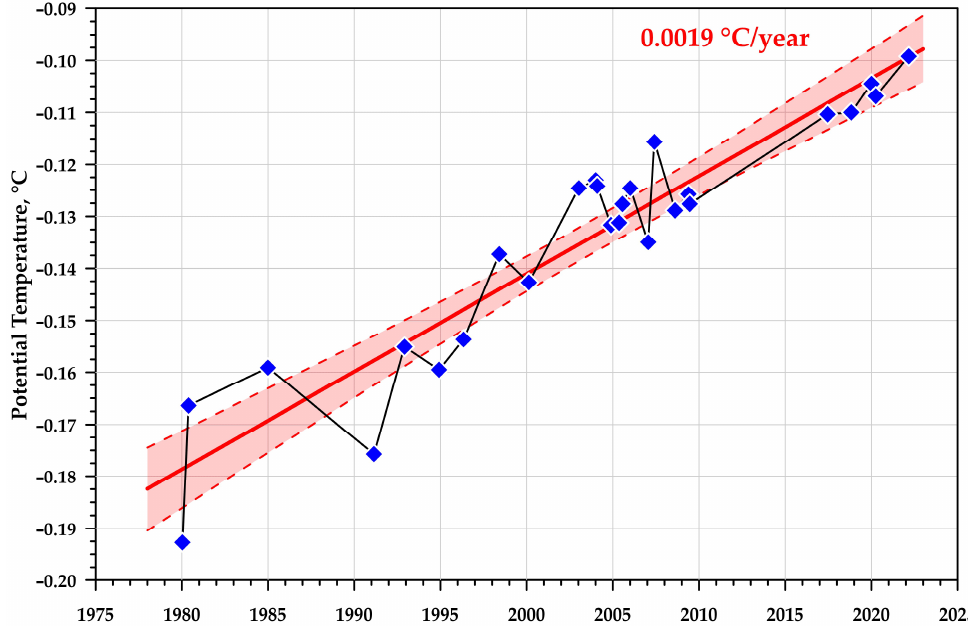
Figure 2. Long-term trend of potential temperature in the bottom layer of the Vema Channel. Blue dots indicate measurements during the visits for distinguishing the warming of AABW in the coldest part of the jet at 31°12° S, 39°18.3 W. The fit curve indicates that the warming rate is 0.0019°C per year. Red color between two dashed lines shows the 95% confidence interval.